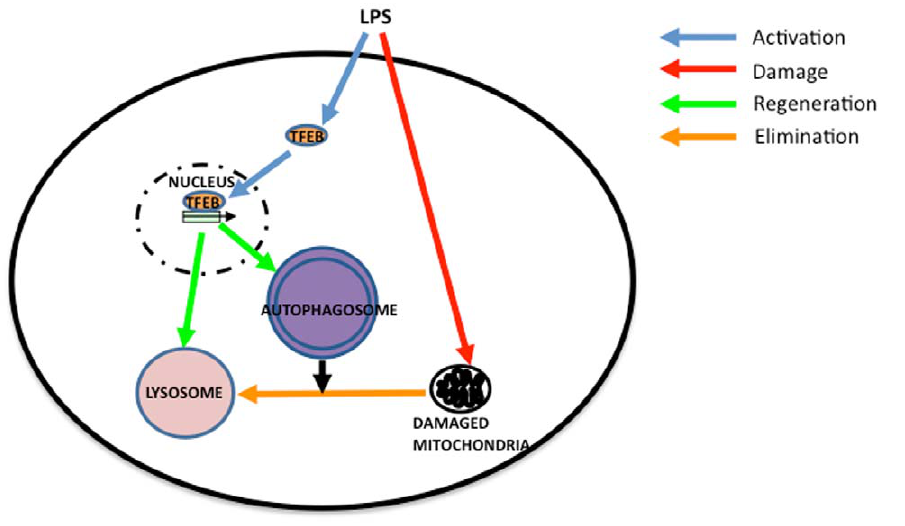
Figure 9. Model of organelle turnover during LPS administration in rat heart. TFEB pathway of autophagosomal and lysosomal biogenesis is activated in the heart to facilitate the elimination of damaged mitochondria during LPS administration. CoPPIX enhances the pathway and accelerates organelle turnover.